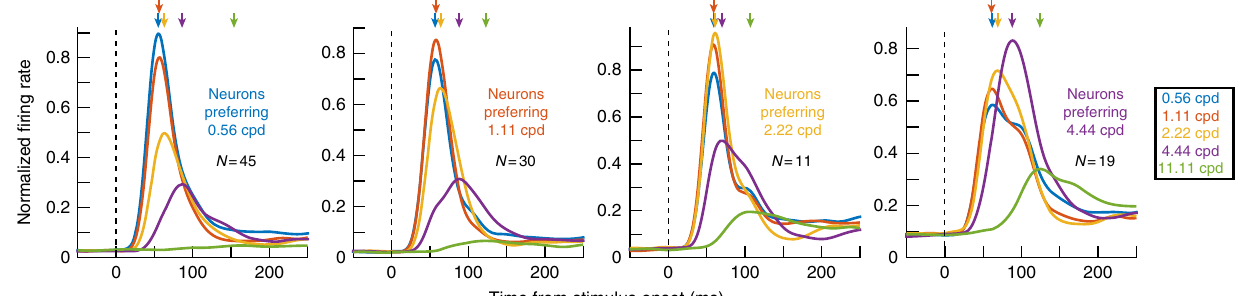
Fig. 3 Dissociation between primate SC response strength and latency as a function of spatial frequency. The effect in Fig. 2 persisted for neurons preferring other spatial frequencies. In each panel, we took only neurons preferring one spatial frequency out of the fi ve that we presented in the experiment (e.g. 0.56 cpd in the leftmost panel and 4.44 cpd in the rightmost panel, and so on for the other panels). As expected, gratings of non-preferred spatial frequencies expectedly evoked weaker visual responses than the preferred spatial frequency in each panel (e.g. 0.56 cpd had the highest fi ring rate in the leftmost panel, and 4.44 cpd had the highest fi ring rate in the rightmost panel, and so on for the other panels). However, regardless of visual sensitivity to a given spatial frequency, the rank ordering of visual burst times as a function of spatial frequency was similar across all panels (indicated here schematically by the downward arrows highlighting the time of peak visual response for each spatial frequency). For example, responses to 2.22 and 4.44 cpd gratings always came later than responses to 0.56 and 1.11 cpd gratings regardless of which spatial frequency the neurons preferred. Note that we did not have enough neurons preferring 11.11 cpd to include in this analysis (see Figs. 6 and 7 for reasons why). The numbers of neurons contributing to each panel are indicated in the fi gure